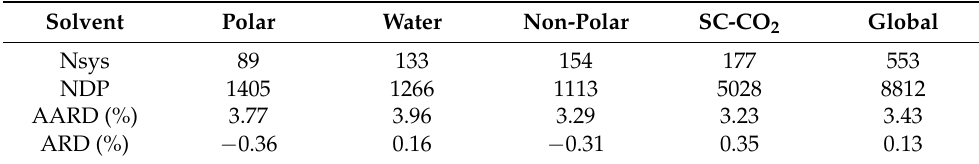
Table 1. Performance of the D 12 model for each subset of systems and for the global